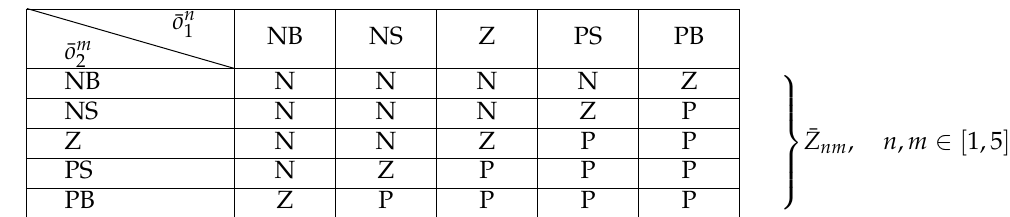
Table 1. Fuzzy Rules.